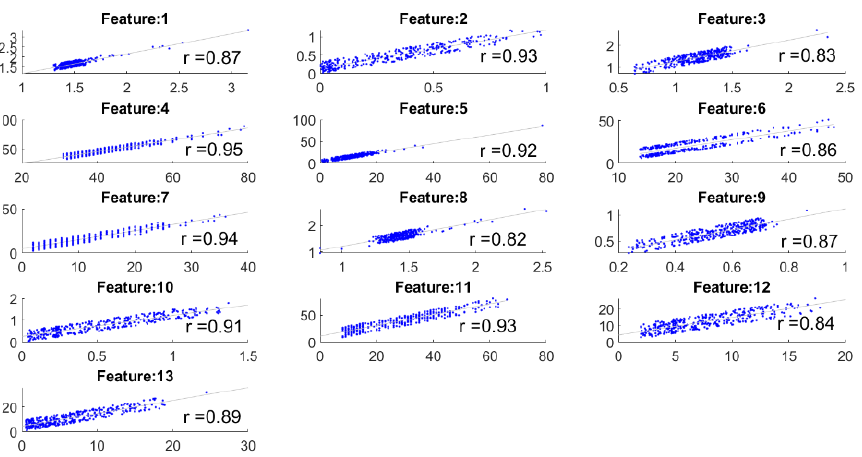
Figure 12. Correlation coefficients between the features extracted both by the eyeT and camera systems.